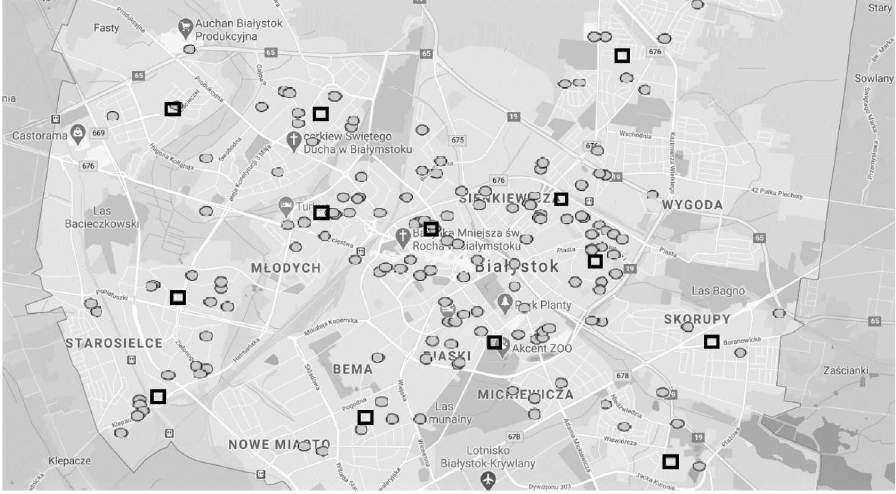
Figure 2. The optimal deployment of AED devices in Białystok plotted correspond to the optimal locations of AED devices. The map